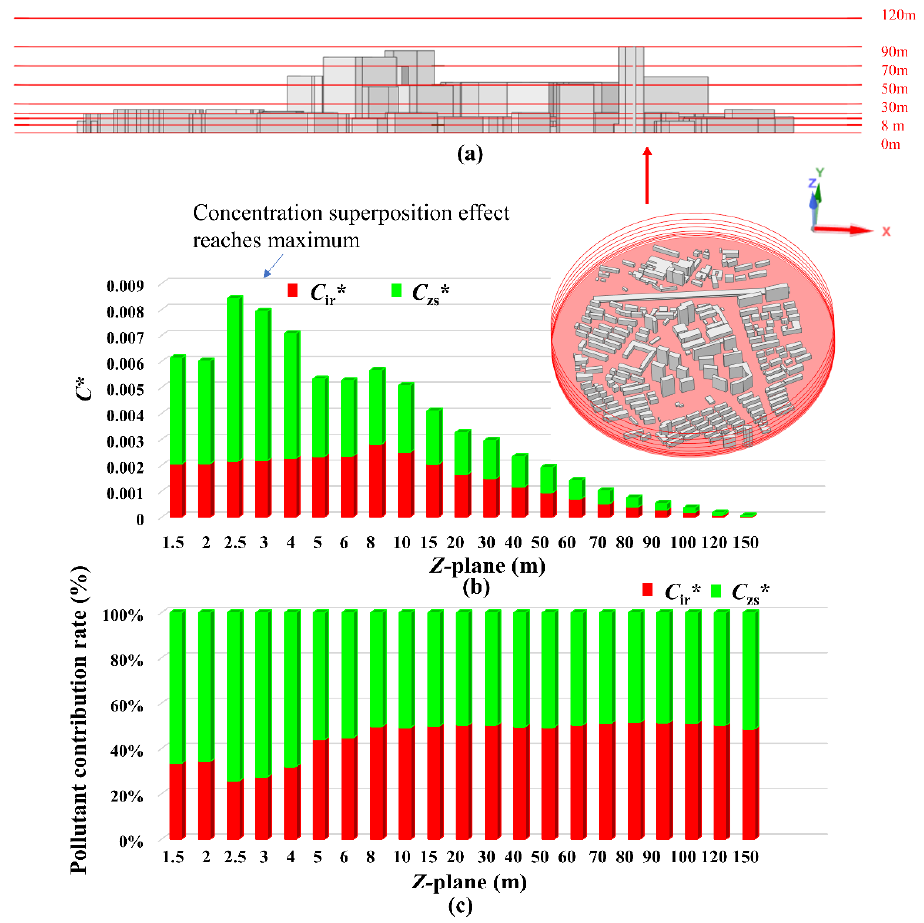
Figure 12. ( a ) Cross–section display of study area; ( b ) Mean normalized air pollutant concentration ( C *); ( c ) Proportion of pollutant contribution rate on cross–sections at different heights.